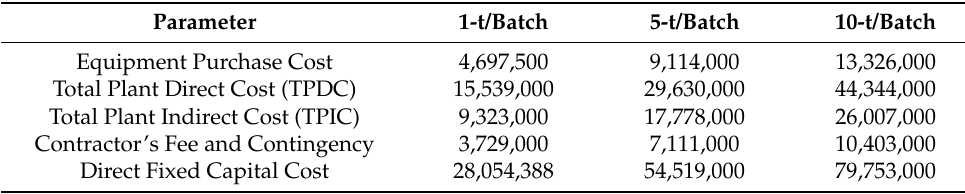
Table 5. Fixed capital estimate summary for different scale of Ti powder plant in USD.